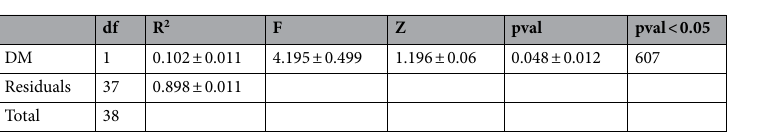
Table 1. Summary ANOVA table for the evaluation of the evolutionary covariation between WPI and DM through PGLS. Values given are means ± standard errors, as well as the number of significant p-values over 1000 phylogeny iterations (pval <